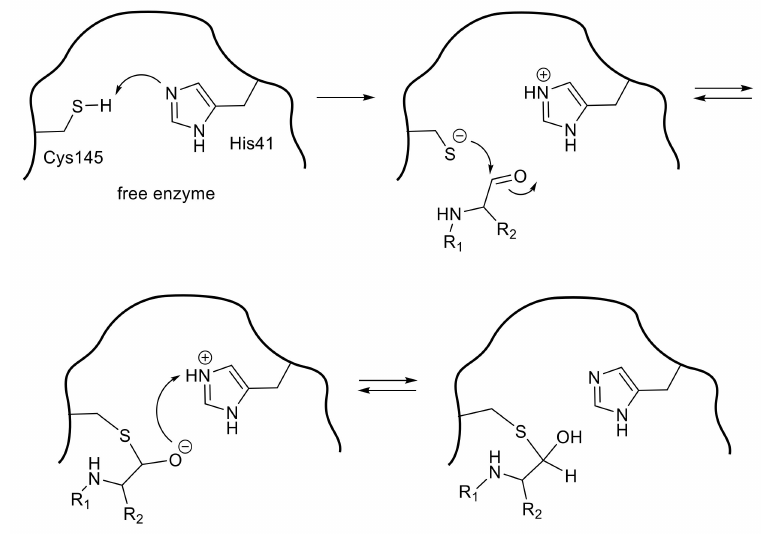
Figure 9. Nucleophilic addition reaction to peptide